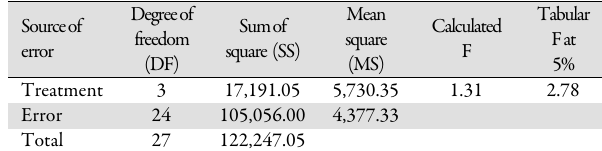
Table 6. ANOVA for the yield of tomato in the consumptive use